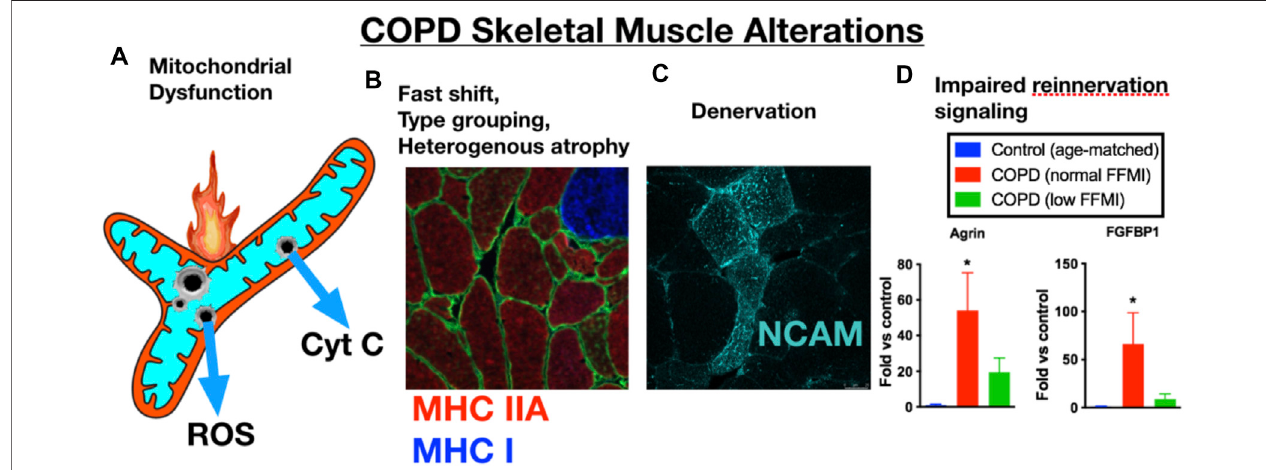
FIGURE1| COPDpatientlimbmuscleischaracterizedbyavarietyofalterations thatinclude (A) mitochondrial dysfunction[reduced respiratorycapacity,elevated reactive oxygen species (ROS), and evidence of an increased frequency of mitochondrial permeability transition events causing release of cytochrome c, (B) a fast fi ber shift and fast fi ber type grouping indicative of recurring denervation-reinnervation events, (C) accumulation of muscle fi bers expressing markers of denervation (e.g., neural cell adhesion molecule (NCAM)], and (D) a transcriptional pro fi le suggesting an impaired reinnervation response. Images and data in panels (B – D) are adapted from (Kapchinsky et al., 2018). MHC IIA = type IIa fi bers; MHC I, type I fi bers; FFMI, fat free muscle index; FGFBP1, fi broblast growth factor binding protein 1 (promotes collateral sprouting of neighboring motoneurons to promote reinnervation).